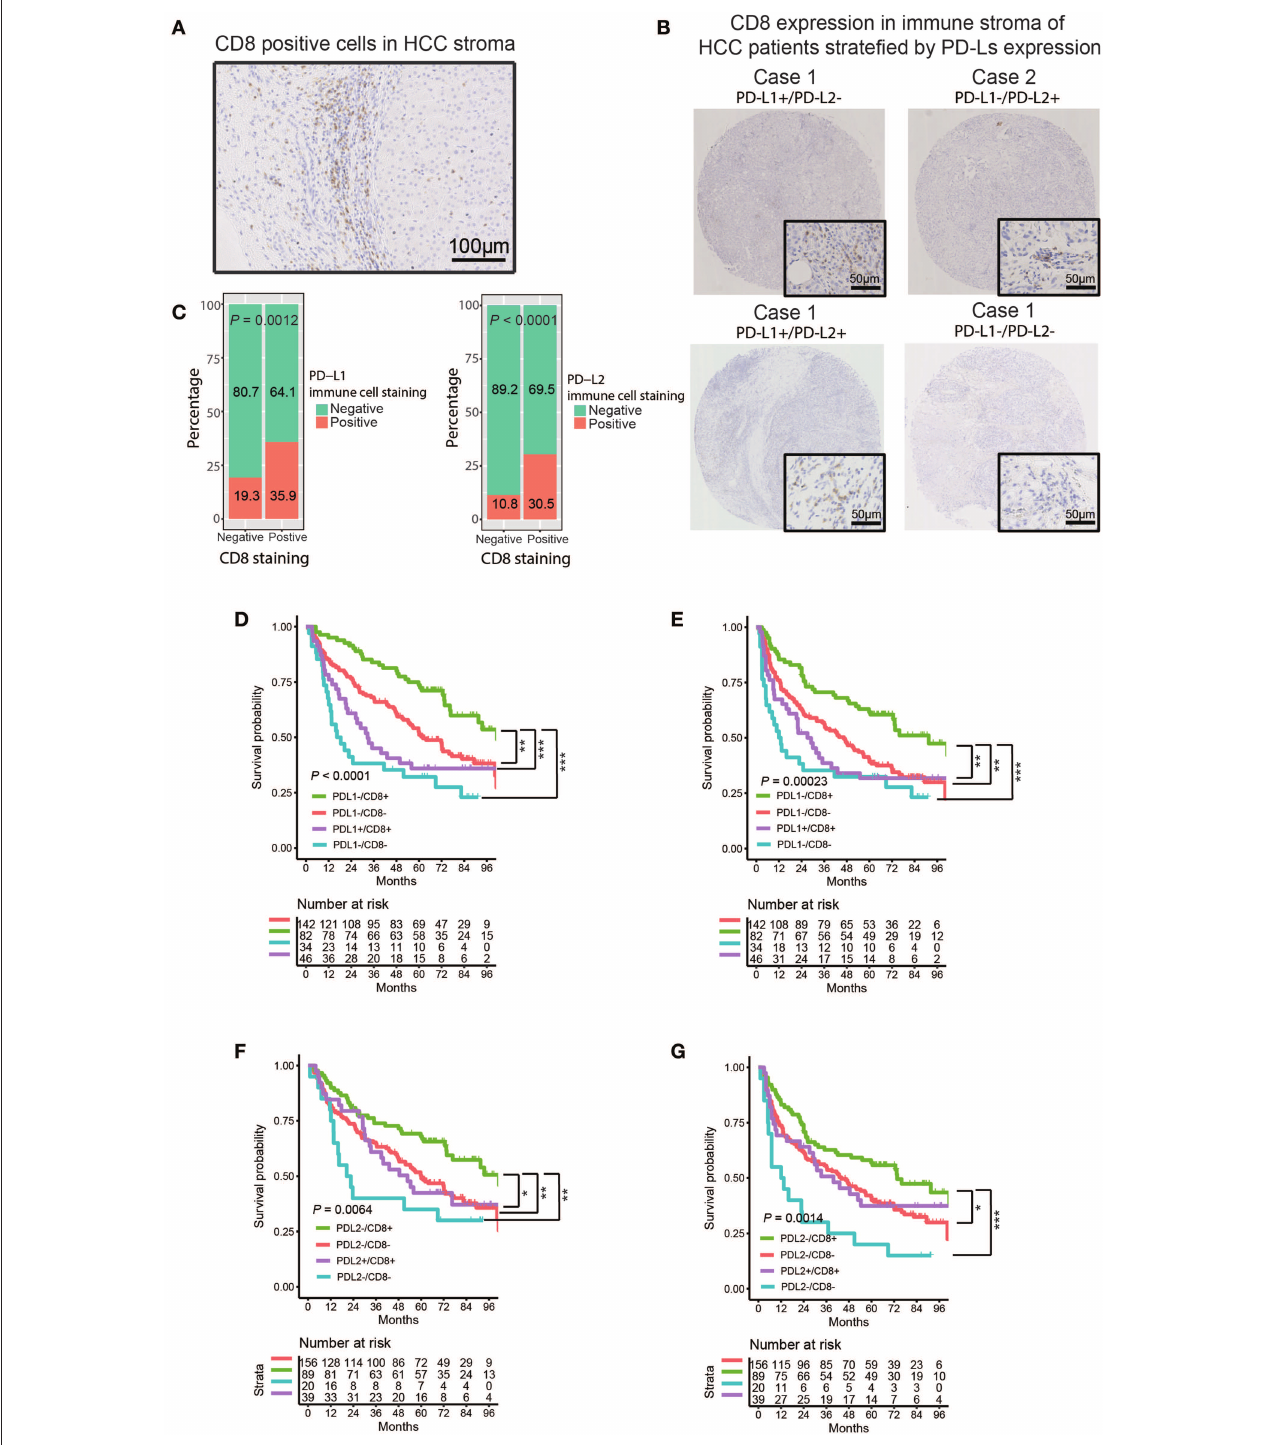
FIGURE 3 | Correlation between PD-Ls and CD8 + T cell infiltration in HCC immune stroma. (A) Representative images showing CD8 expression in HCC immune stroma. (B) Representative CD8 expression in immune stroma of HCC patients stratified by PD-Ls expression. (C) Proportions of HCC tumor samples expressing CD8 stratified by PD-L1 and PD-L2 expressed by immune stroma. (D–G) Kaplan-Meier curves of OS (D, E) and DFS (F, G) stratified by PD-L1 (left panel) and PD-L2 (right panel) in combination with CD8 expression in immune stroma. * P < 0.05; ** P < 0.01; *** P < 0.001.